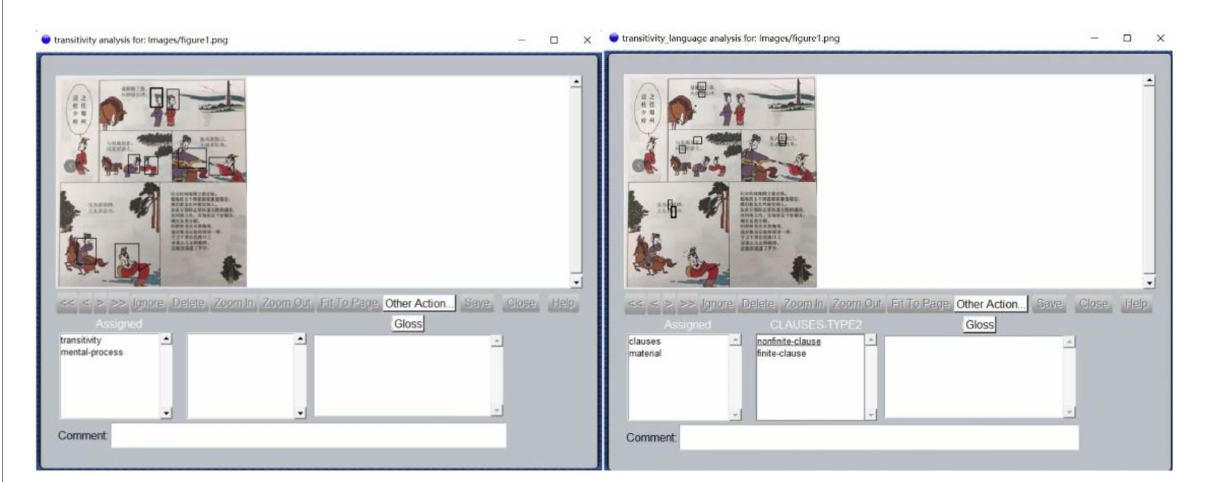
FIGURE 4 Annotating the images (left) and language (right) of the comic strips (Cai, 2014) with UAM Image Tool 2.1. Images reproduced with permission from Shang Dong People Press.